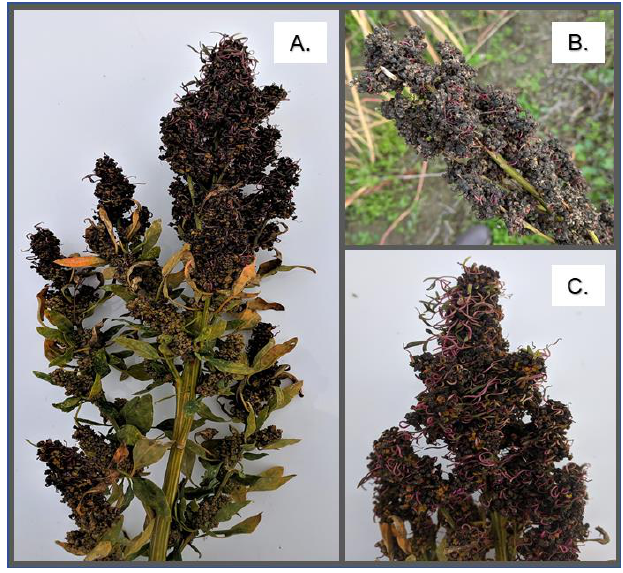
Figure 1. Quinoa preharvest sprouting (PHS). Panels A-C show inflorescences severely impacted by PHS in breeding line ‘3964′ from the 2015 and 2019 field seasons. Plants from the 2015 field season ( A and C ) were grown in Quilcene, WA on Dharma Ridge Farm. Plants from the 2019 field season ( B ) were grown in Skagit Valley, WA.